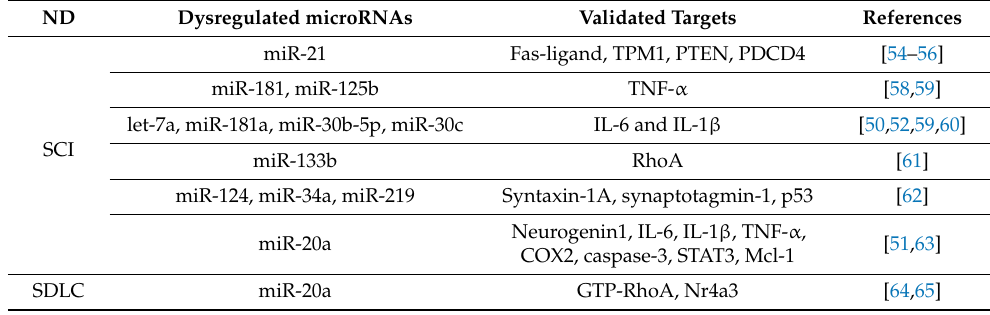
due to neurological disorders (ND). SCI—spinal cord injury, SDLC—spinal dorsal column lesion, TBI—traumatic brain injury, AD—Alzheimer’s disease, TPM1—tropomyosin alpha-1 chain, PTEN— phosphatase and tensin homolog, PDCD4—programmed cell death protein 4, TNF- α —tumor